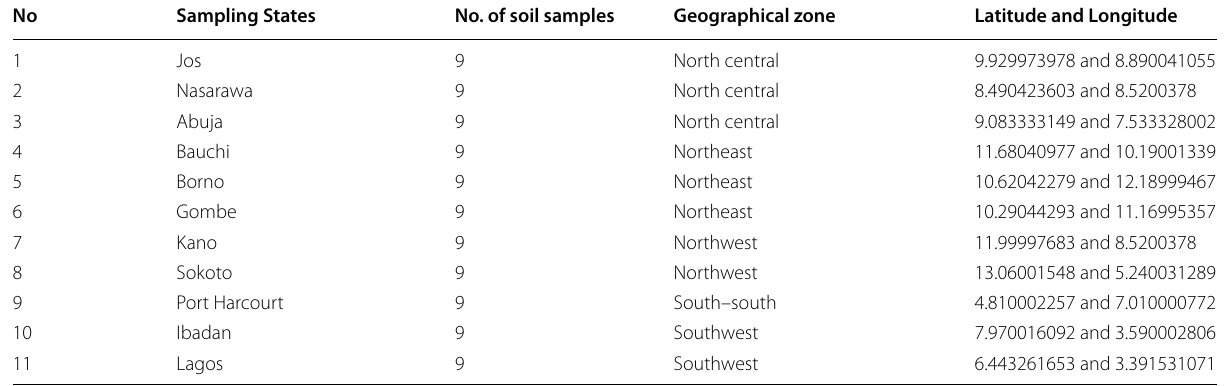
Table 1 Soil sample collection states and geographical